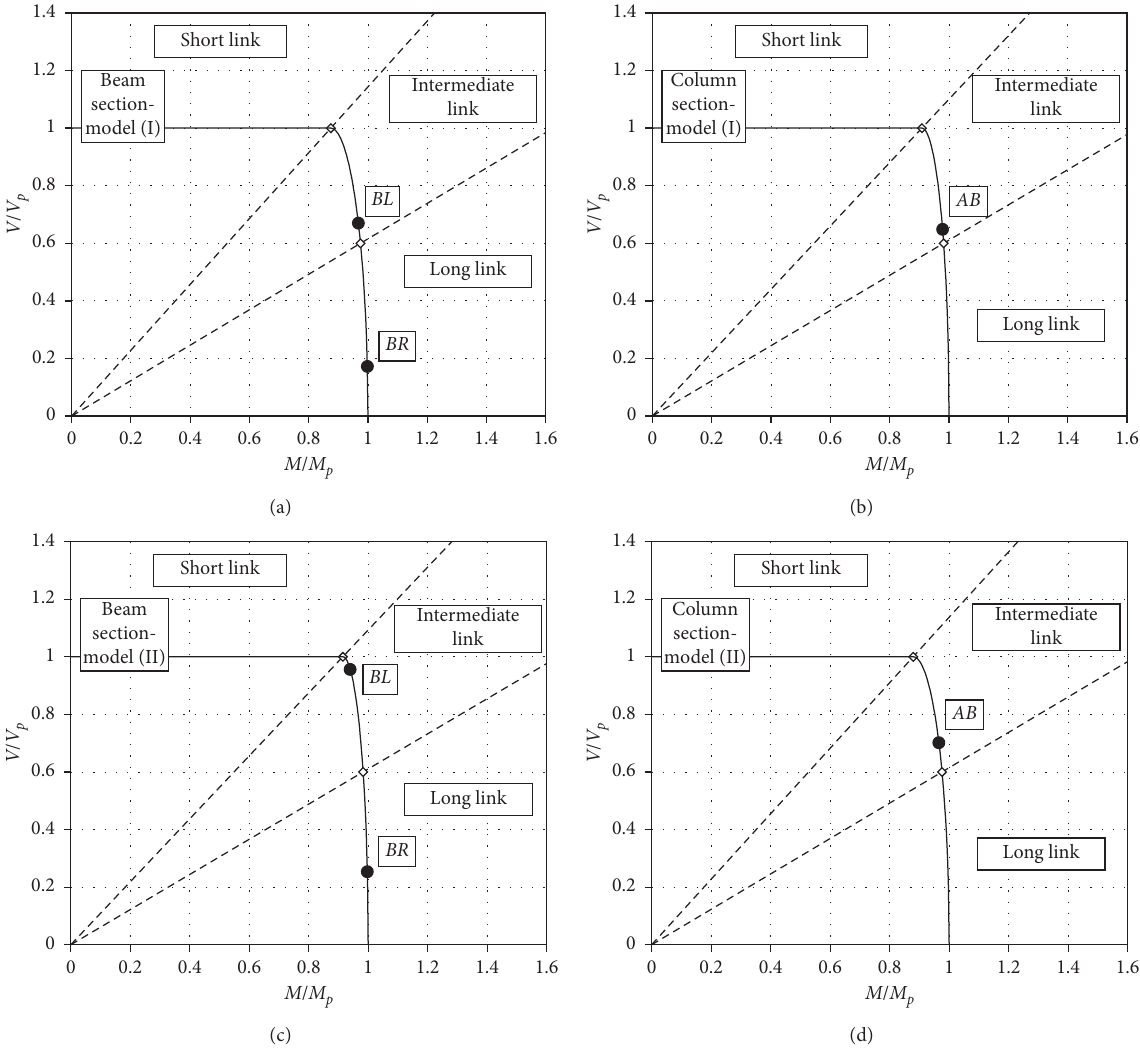
Figure 4: The moment-shear interaction diagram for T-part elements’ sections. For the models studied, the results of the relationships given in Section 4 for determining the hierarchy criteria are shown in Table 2.